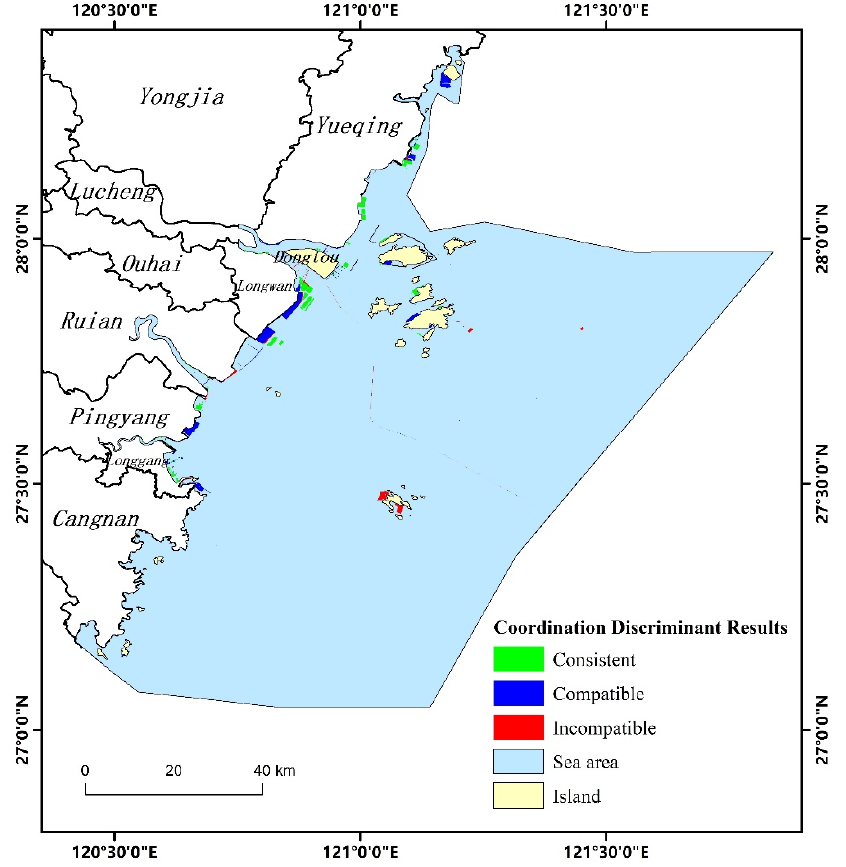
Figure 5. Coordination analysis between sea area utilization in Wenzhou from 2013 to 2020 and Wenzhou Marine Functional Zoning (2013–2020).